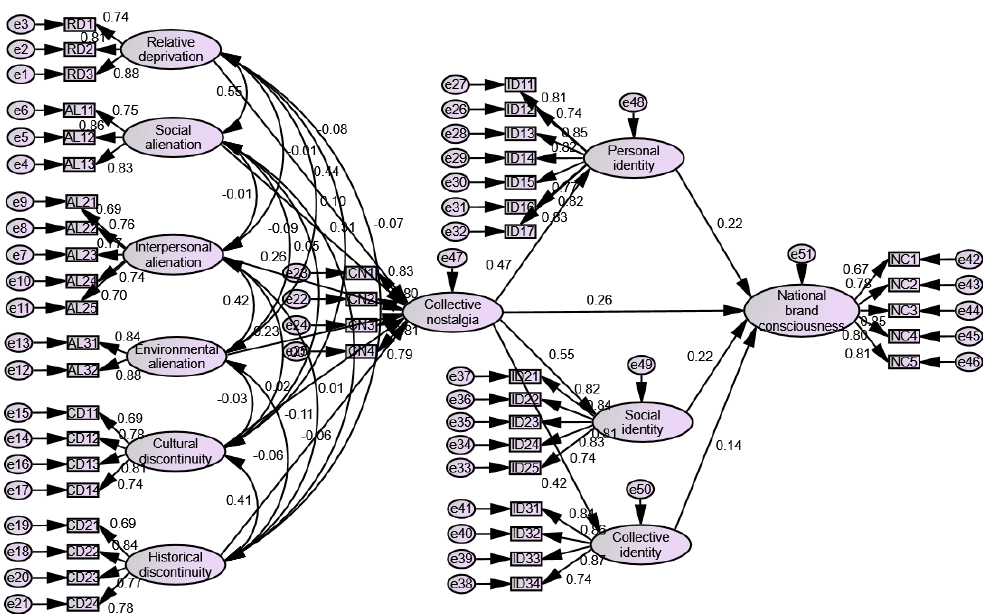
Figure 2. Structural equation model.